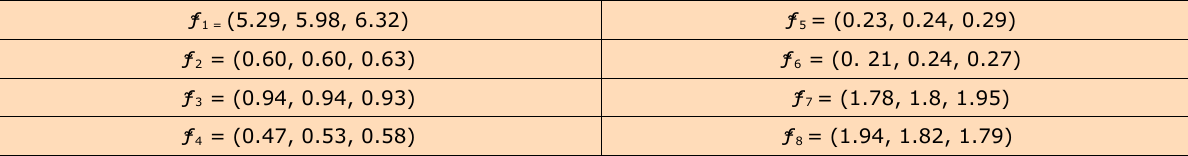
Table 9. value of geometric mean (ƒ̃ i ) for all hazard